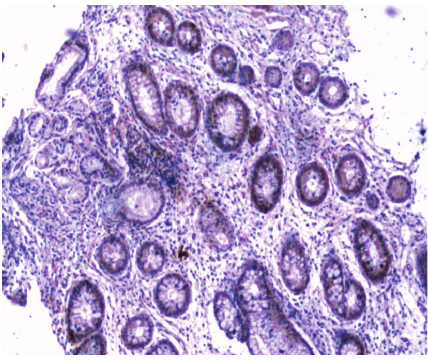
Figure 4: Positive particle for anti-IL-10 (1 × 40).